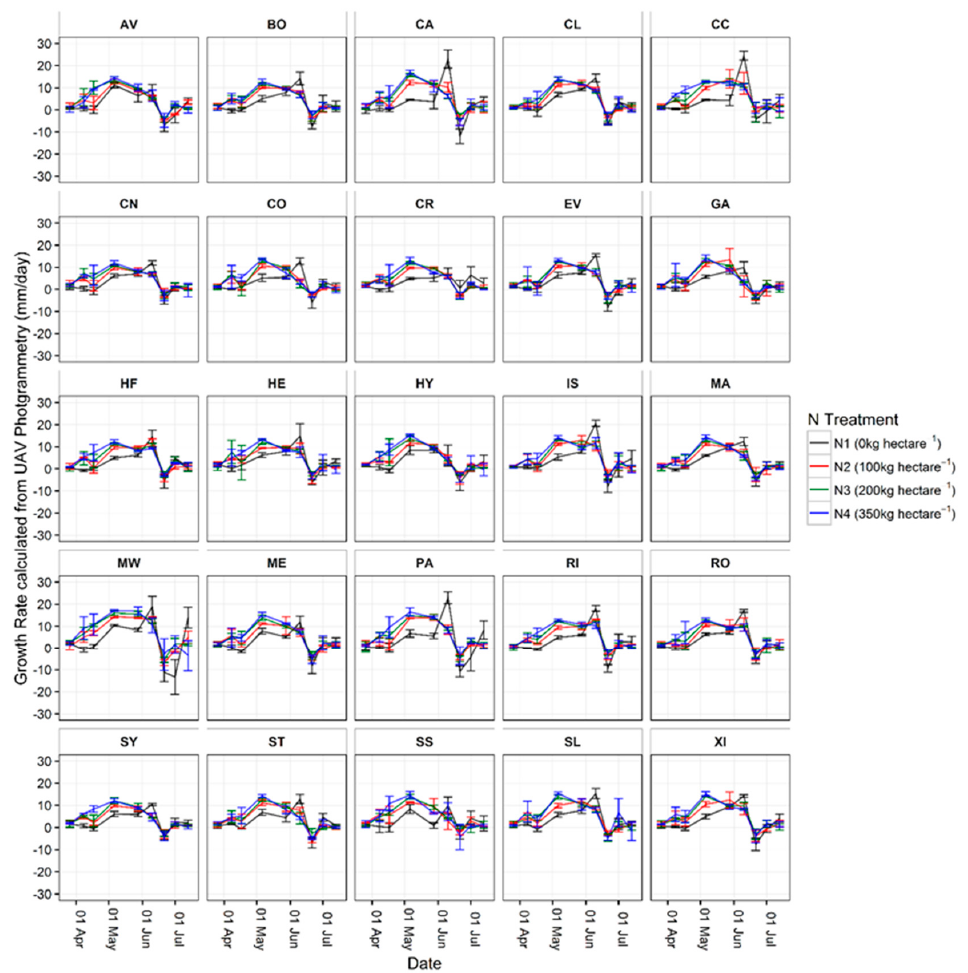
Figure 12. Mean growth rate inferred from height increase of wheat varieties subjected to different nitrogen fertiliser treatments. Growth rate is calculated from the data of Figure 12 and the time interval between the dates of each normalised digital surface model. Crop varieties are referred to by their code as set out in Table 2 and all data are the means of three replicate plots, except Maris Widgeon N1 on the 4 June 2015 which is the mean of two replicates due to plot 298 being omitted because of noise in the model.